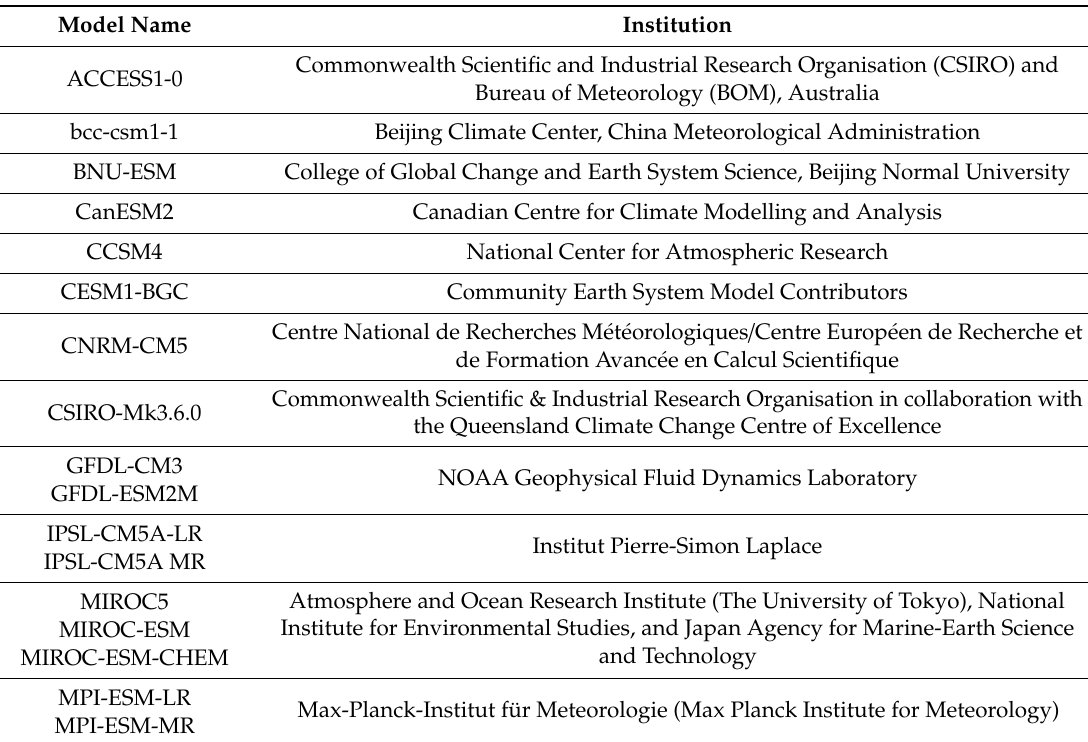
Table 5. Details of Global Circulation Models (GCMs) used in the